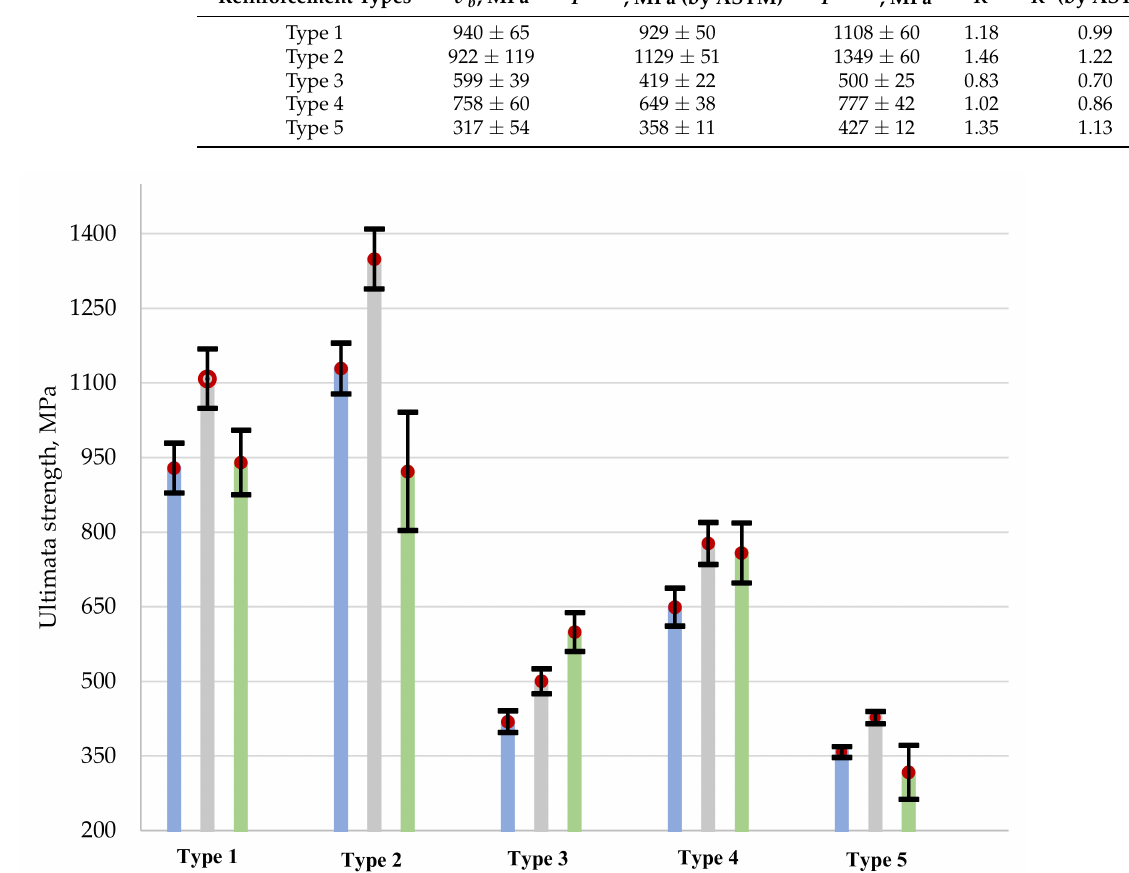
Figure 8. The relationship between the ultimate strength and the reinforcement type in composite specimens. The open hole tensile ultimate stress under ASTM D 5766 F OHTu —blue line; the open hole tensile ultimate strength of specimens with the concentrator F (cid:48) OHTu —grey line; ultimate stress of solid specimen σ b —green